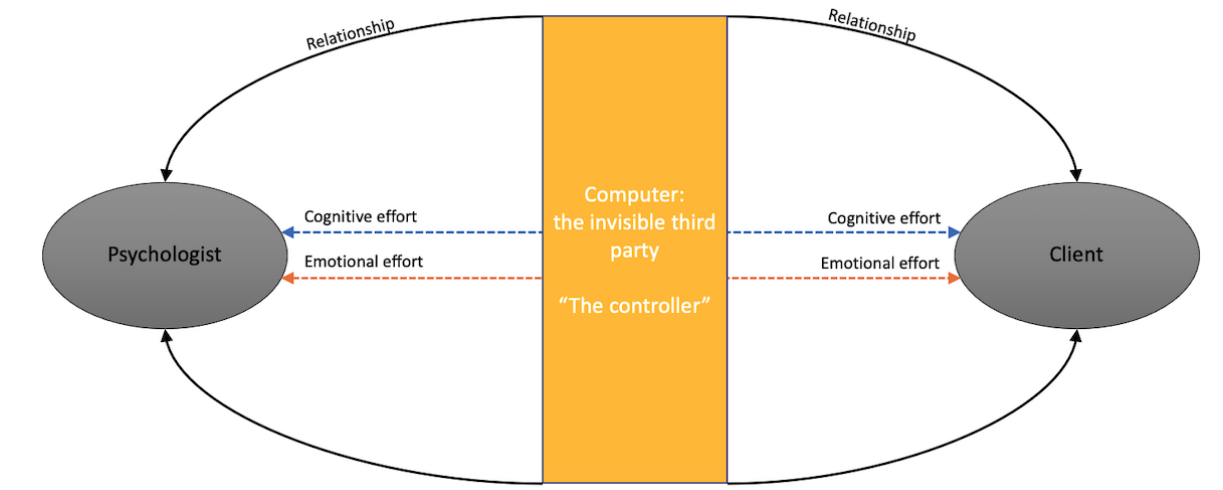
Figure 3. Videoconference psychotherapy relationship model of the invisible third